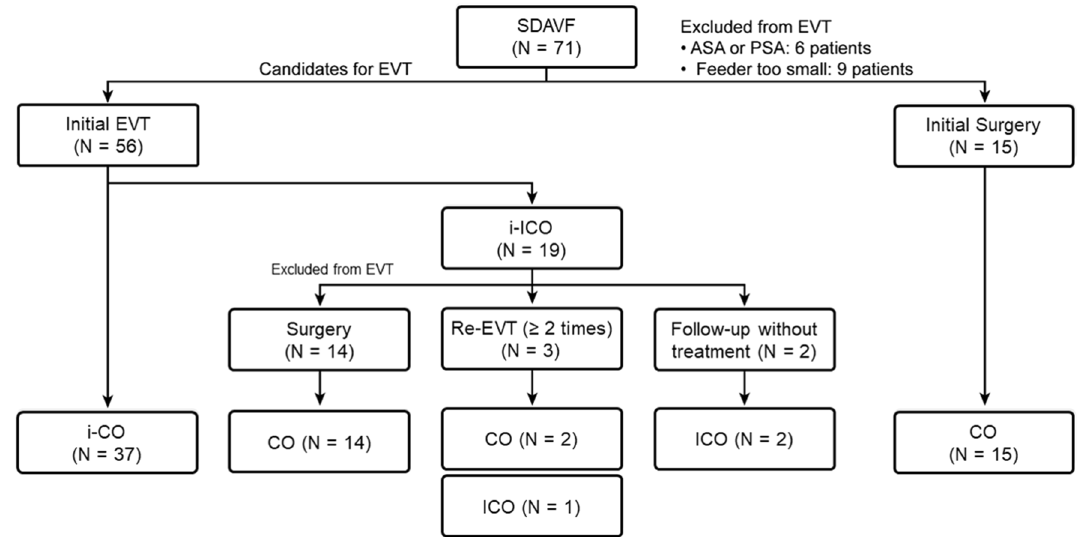
Figure 2. Flow chart of treatment decisions upon initial diagnosis of SDAVF and during follow-up periods and angiographic results after each treatment. SDAVF spinal dural arteriovenous fistula; ASA anterior spinal artery; PSA posterior spinal artery; EVT endovascular treatment.